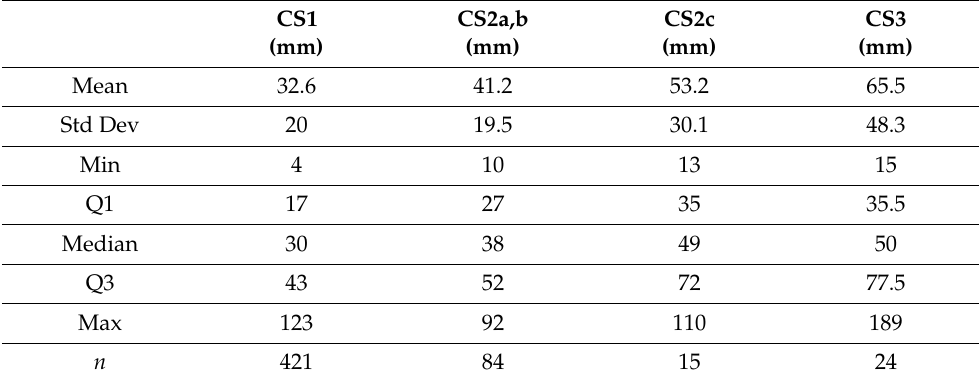
Table 9. Distribution of tumour sizes stratified by clinical stages (CS) in germ cell tumours (SE, NS). CS1 (mm)